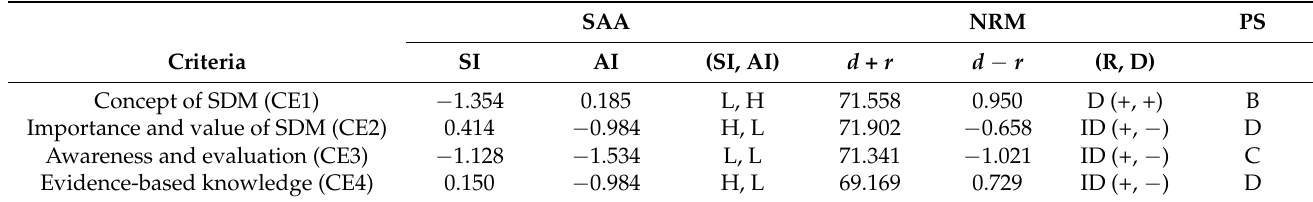
Table 6. The development strategies of the CE (concept and evaluation)